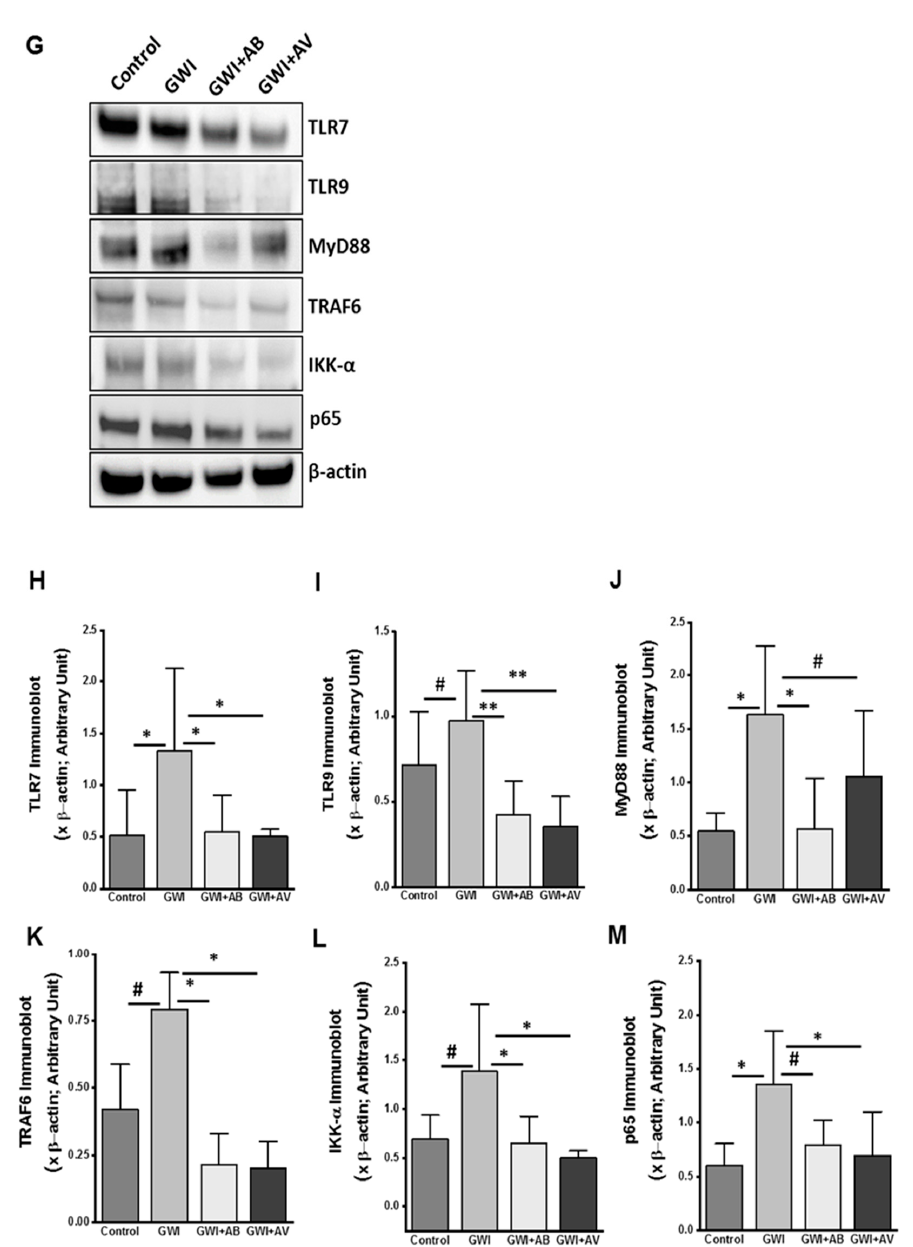
Figure6. GutviraldysbiosisactivatesTLR7andTLR9pathwayinGWI.Representativeimmunofluorescence images of small intestine showed ( A ) TLR7 (red) and MyD88 (green); ( B ) TLR9 (red) and MyD88 (green) and ( C ) TRAF6 (green) immunoreactivity in Control, GWI (Gulf war chemical exposed mice), GWI + AB (Gulf War chemical and antibiotic exposed mice), and GWI + AV (Gulf War Chemical and antiviral-treated mice). All intestine sections were counterstained with DAPI (blue) and 3–15 images were taken from the different microscopic field of each group at 20 × or 40 × analysis of colocalized area (yellow, calculated as % ROI) of TLR7-MyD88 ( D ), TLR9-MyD88 ( E ), and immunoreactivity of TRAF6 ( F ) was plotted as a bar graph. ( G ) Western blot analysis of TLR7 and TLR9, and its signaling cascade molecules such as MyD88, TRAF6, IKK- α , and p65 were plotted as immunoblot. ( H – M ) Morphometry analysis of all immunoblot ( n = 3–8) normalized against β -actin was plotted as a bar graph. Data points were represented with means ± SEM. Statistical significance was calculated using unpaired t -test; # p < 0.1, * p < 0.05, ** p < 0.01. ns = non-significant at p ≥